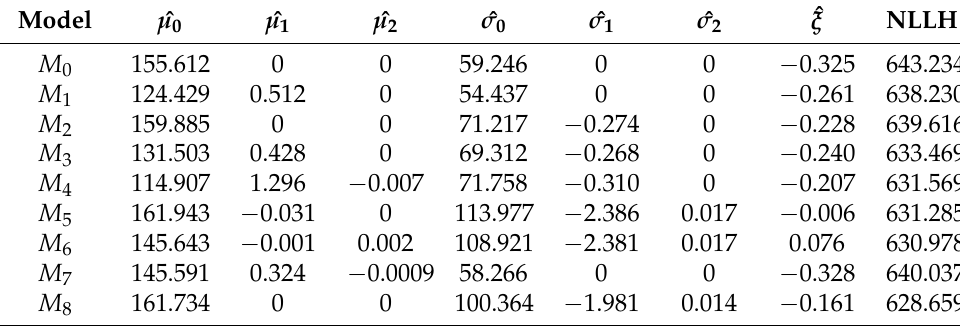
Table 13. Non-stationary GEVD models for Mpumalanga for the period 1904–2017.